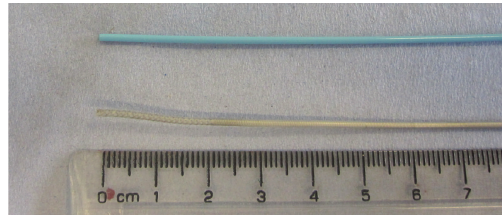
Figure 4: Devices used for clot aspiration: the 4F catheter (top) and the GPTAD (below).